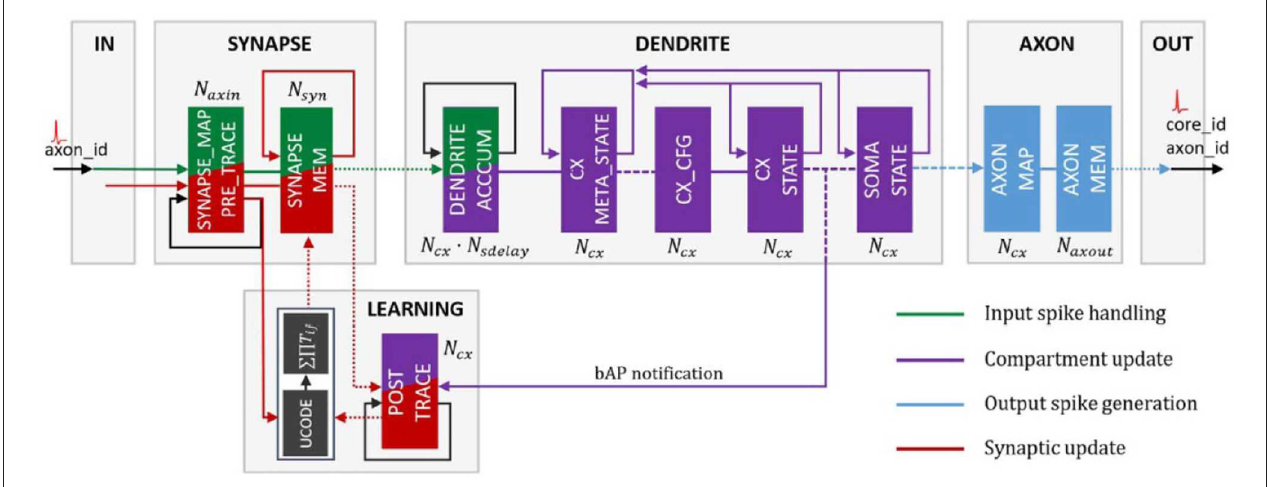
FIGURE 2 | Loihi internal neuron model—Time multiplexed pipeline architecture of a neural unit (Figure 4 in Davies et al., 2018). Reproduced from WikiCommons (2018) .